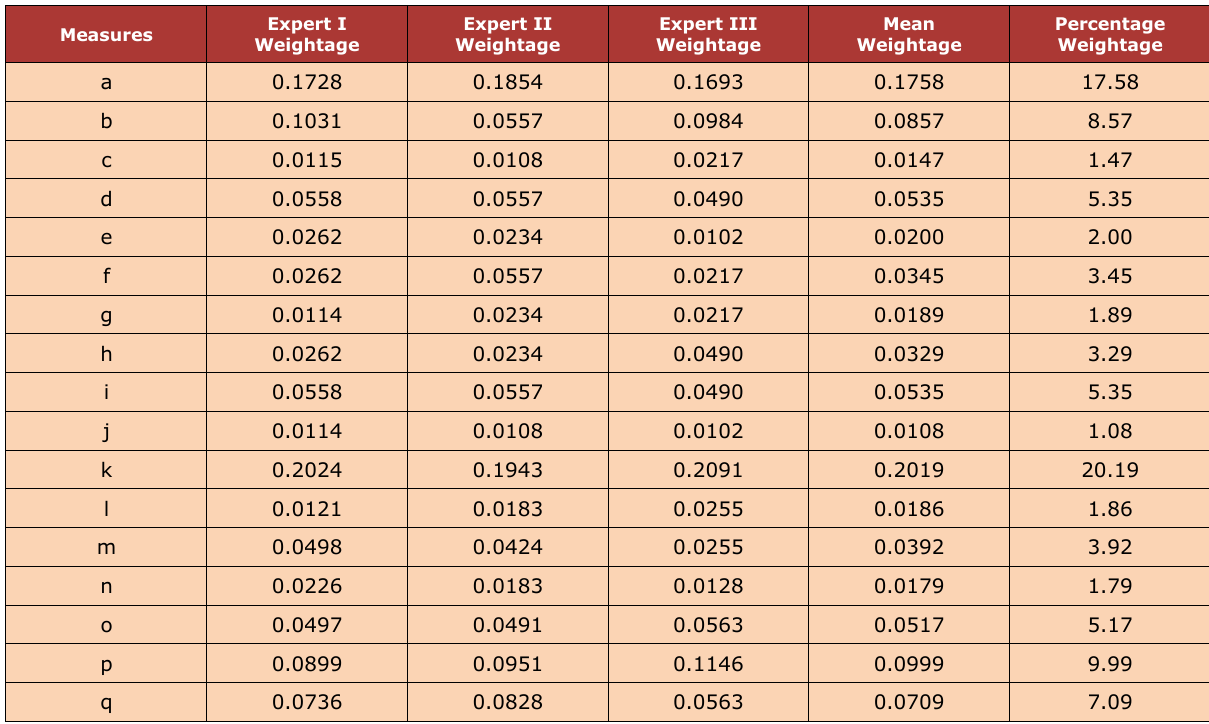
Table 1. Weightage of resource flexibility